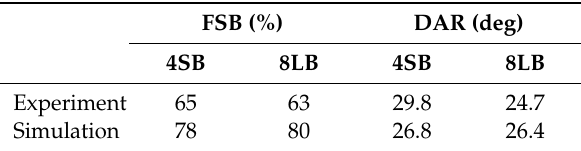
Table 4. Characteristics of the front layer of the bed after 2 min (6 revolutions) of mixing (drum filled at ¼, 4SB: 4 baffles of 1.5 cm, 8LB: 8 baffles of 4 cm).